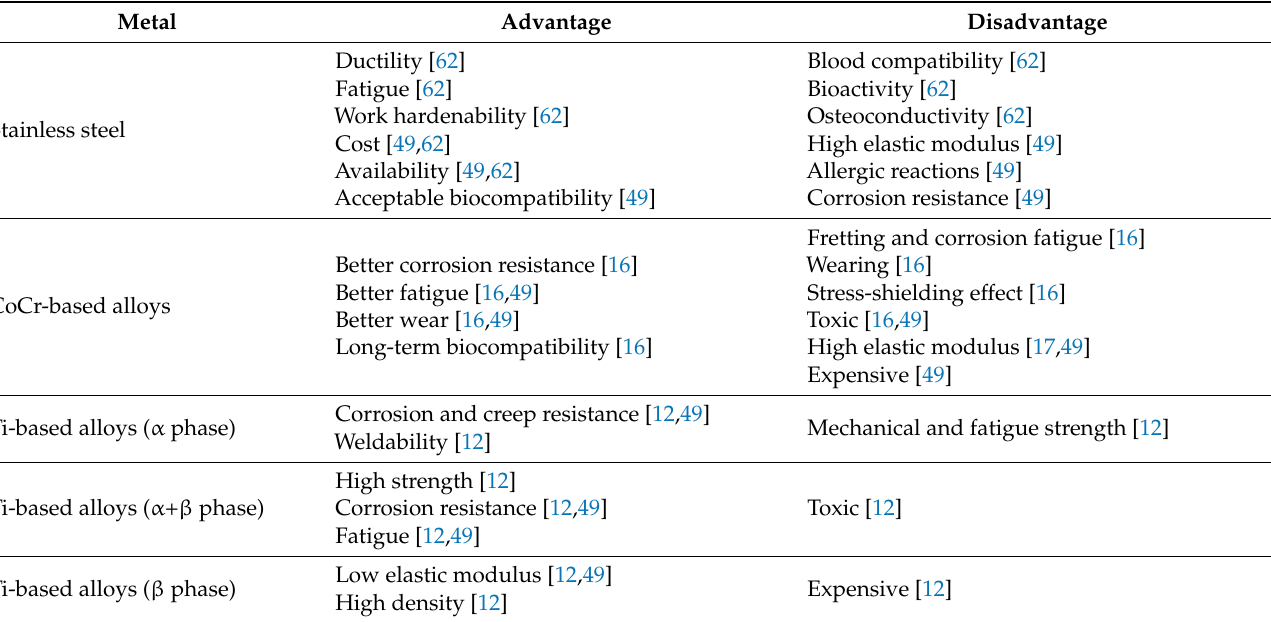
Table 2 summarizes the advantages and disadvantages of metal implant materials. Table 2. Advantages and disadvantages of metal implant